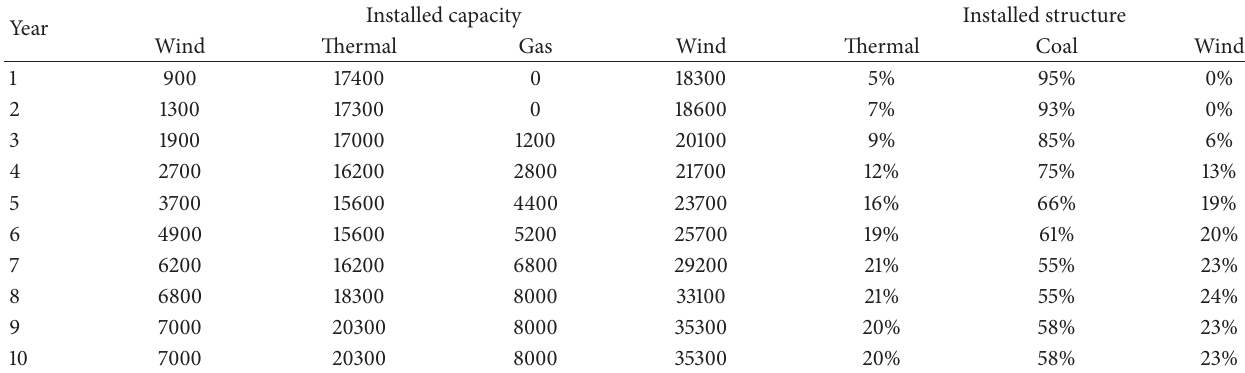
Table 13: System installation capacity and structure in Case 3.